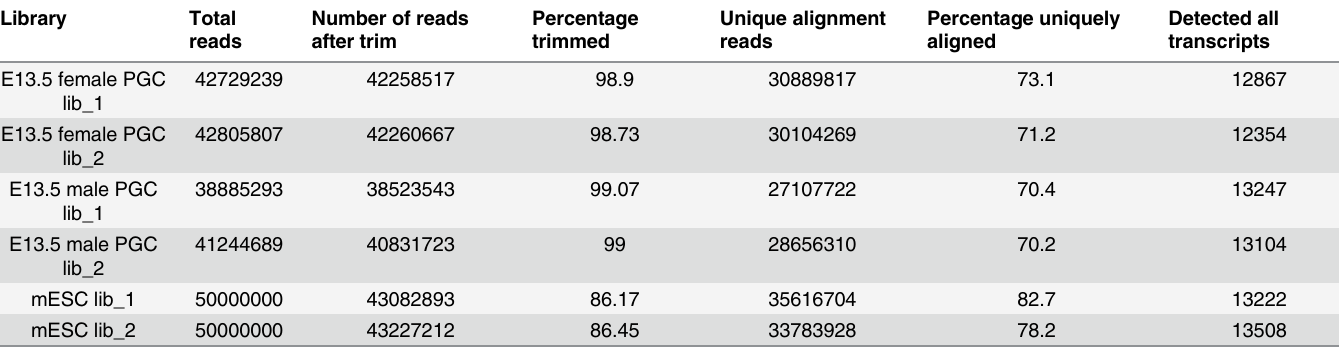
Table 1. Alignment and quantification statistics in each RNA-seq library